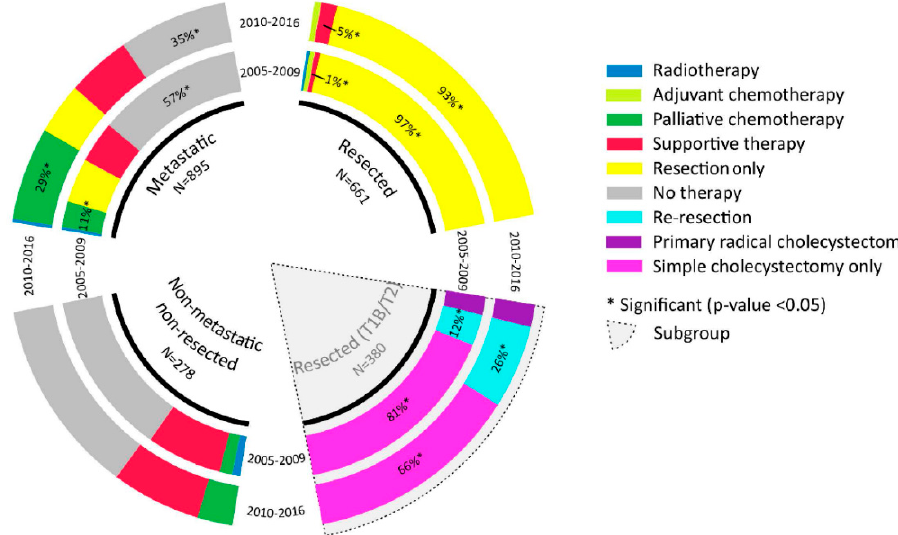
Figure 2. Trends in treatment in resected, non-resected non-metastatic, and metastatic gallbladder cancer (GBC). The grey area represents a subgroup analysis of resected patients with early (T1b/T2) gallbladder cancer. Percentages are only displayed when significant differences ( p < 0.05) between periods were found. Supportive treatment includes endoscopic procedures, biliary drainage and metastasectomy.